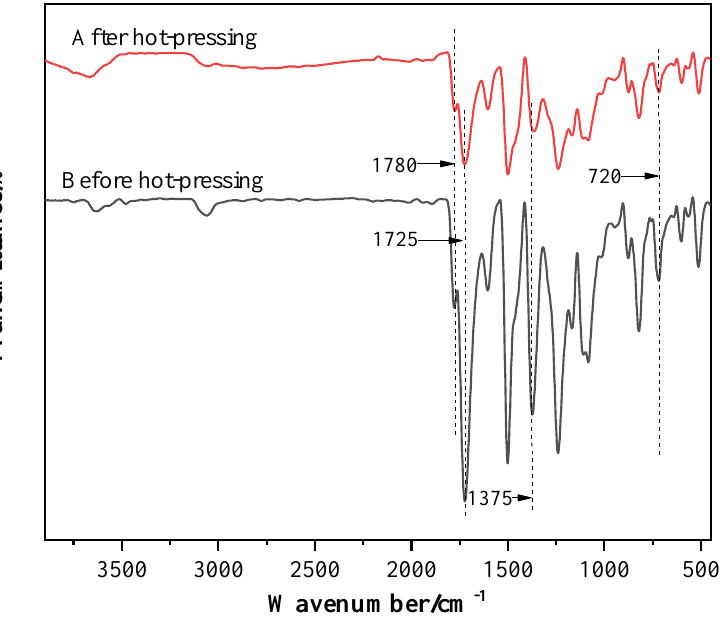
Figure 5. The FT-IR spectra of the molding powder before hot pressing and the molded plate after hot pressing.